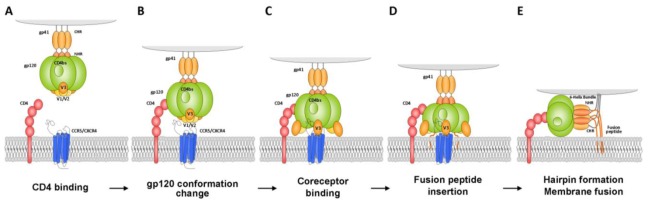
Model for HIV-1 entry. (A and B) Binding of Cluster of Differentiation (CD)4 to glycoprotein (gp)120 exposes a coreceptor binding site in gp120; (C and D) Coreceptor binding causes the exposure of the gp41 fusion peptide and its insertion into the membrane of the target cell in a triple-stranded coiled-coil; (E) Formation of a helical hairpin structure in which gp41 folds back on itself is coincident with membrane fusion.